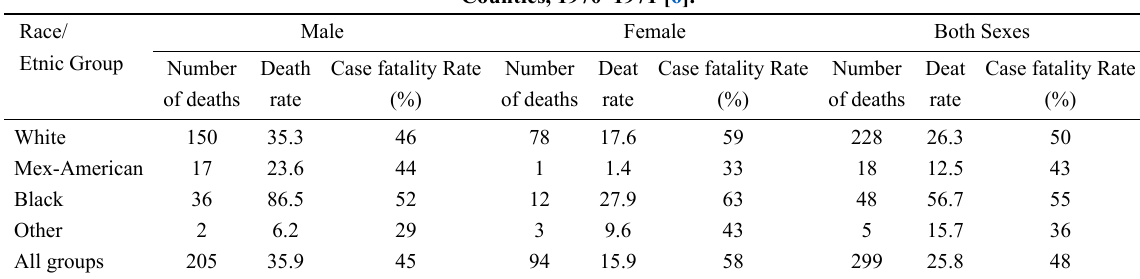
Fig. 1. The annual incidence of Kraus J.F. to Spinal cord injury for one million population from 1970–1971 on the 18 Northern California Counties [6]. Table 1. Annual average deaths by Kraus J.F. per million inhabitants and the fatality rate in the 18 Northern California Counties, 1970–1971